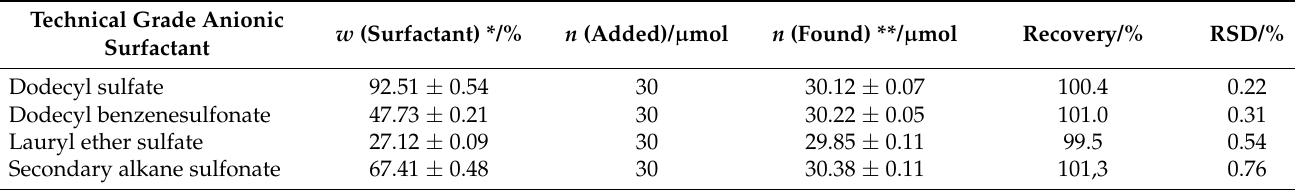
Table 3. Potentiometric titration results of some technical grade anionic surfactants with DMIC (4 × 10 − 3 M) as a titrant and with the DHBI-TPB surfactant sensor as an end-point indicator, with mean values at ± 95% confidence limits. Technical Grade Anionic